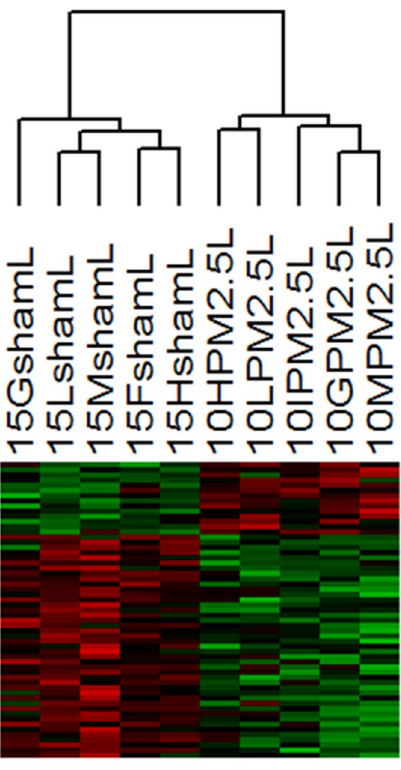
Figure 4. Hierarchical cluster analyses of differentially ex- pressed genes in lung. Hierarchical cluster analyses of 57 DEG between PM2.5win-treated lung (n=5) and sham (n=5) mice using dChip software. Each column represents a mouse and each row represents a gene. Red color indicates genes that were up-regulated and green color indicates genes that were